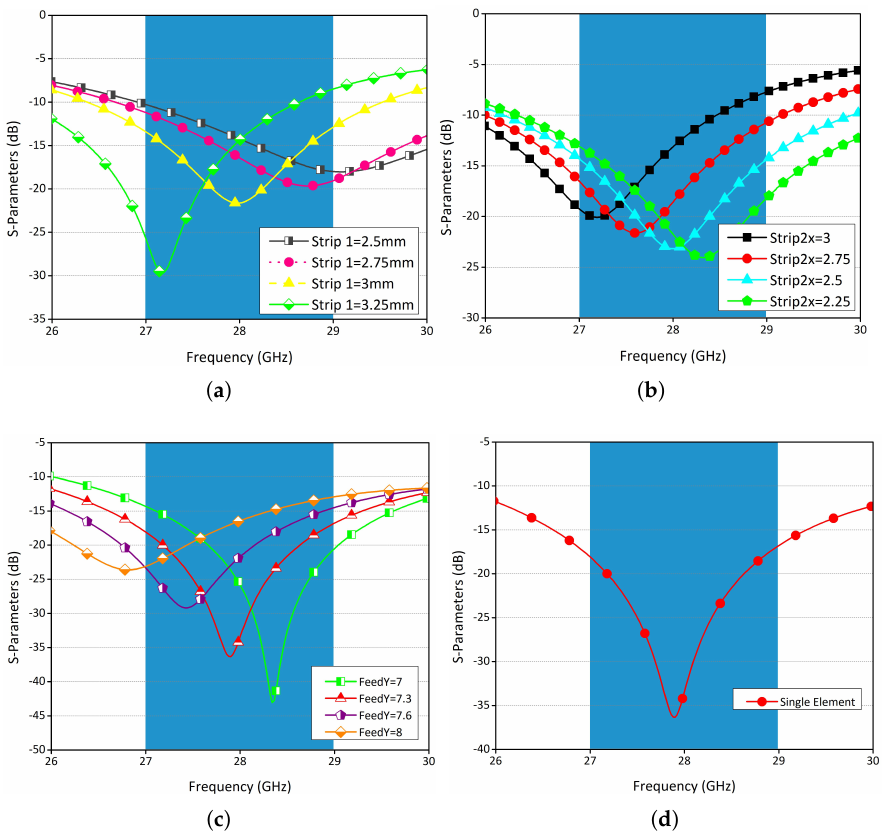
Figure 3. Reflection co-efficient: ( a ) strip 1 sweep; ( b ) strip 2 sweep; ( c ) feed length sweep; and ( d ) final single element.